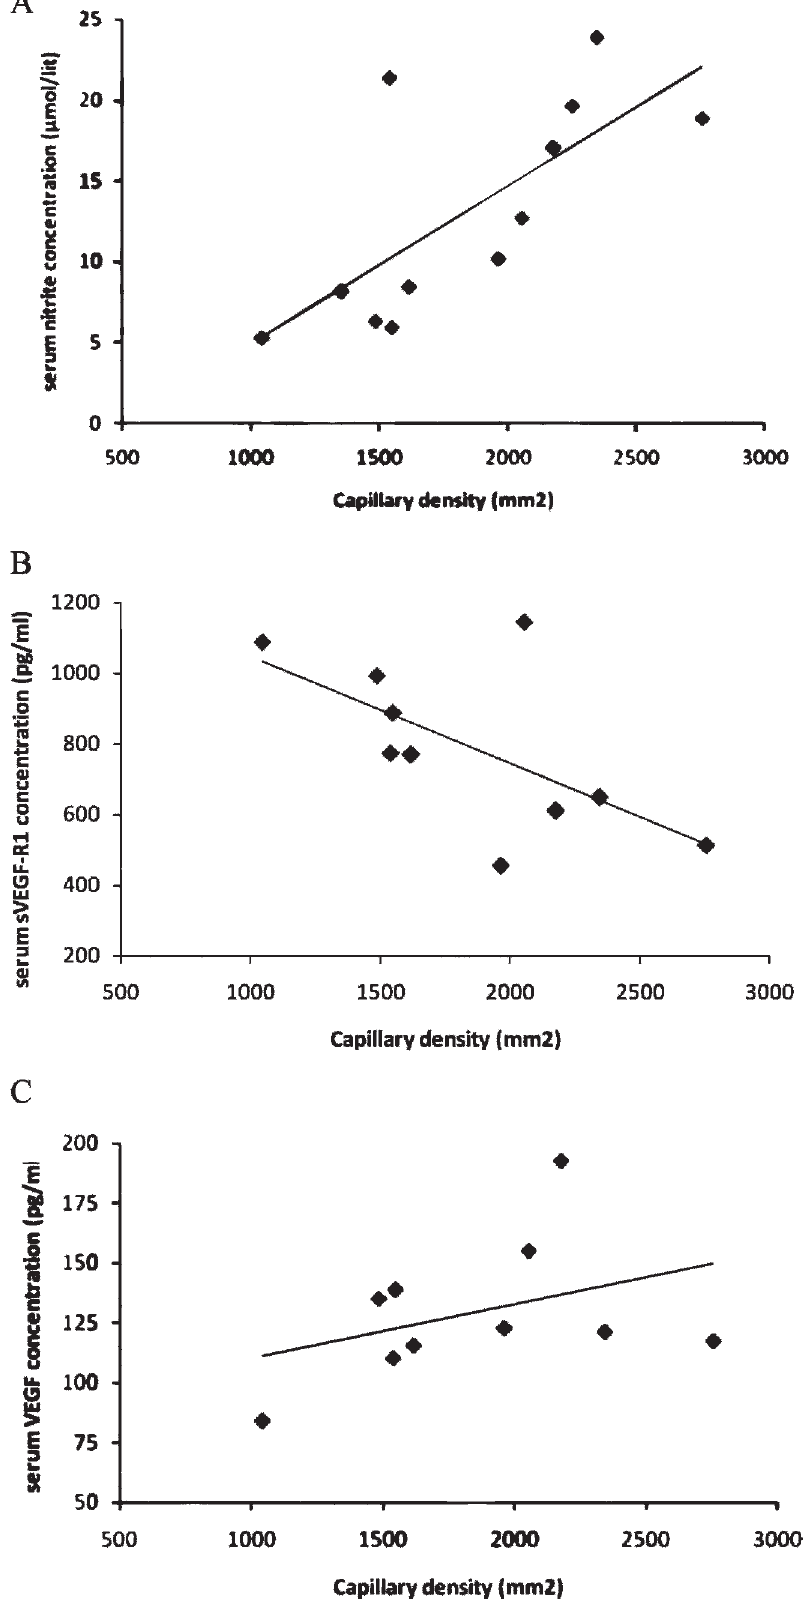
Figure 4 - Correlation between the capillary density in myocardial tissue and the serum nitrite ( r =0.70) (A), sVEGFR-1 (r=-0.69) (B), and VEGF (r=0.40) (C)